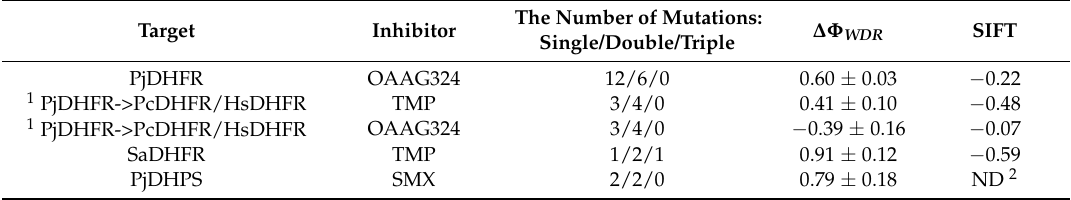
Table 3. Performance of the models on diverse